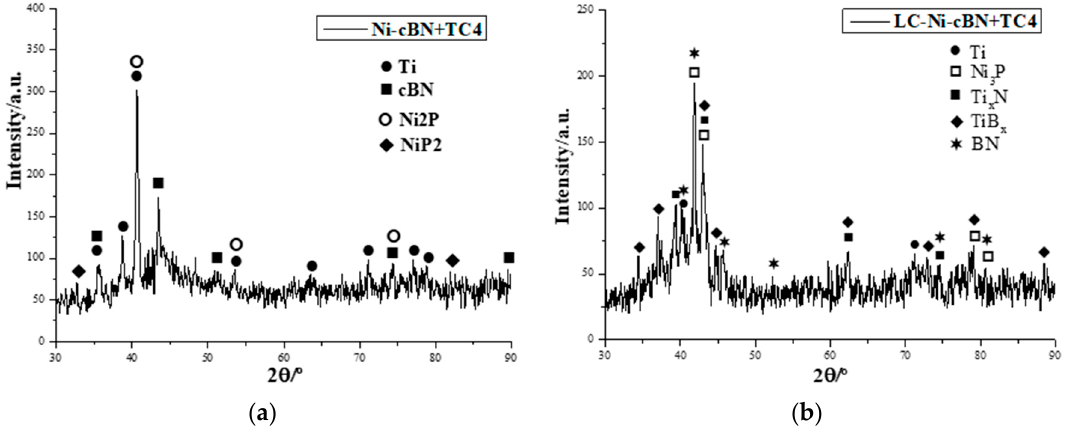
Figure 6. XRD patterns: ( a ) NicBN/Ti6Al4V composite powder; and ( b ) NicBN/Ti6Al4V composite